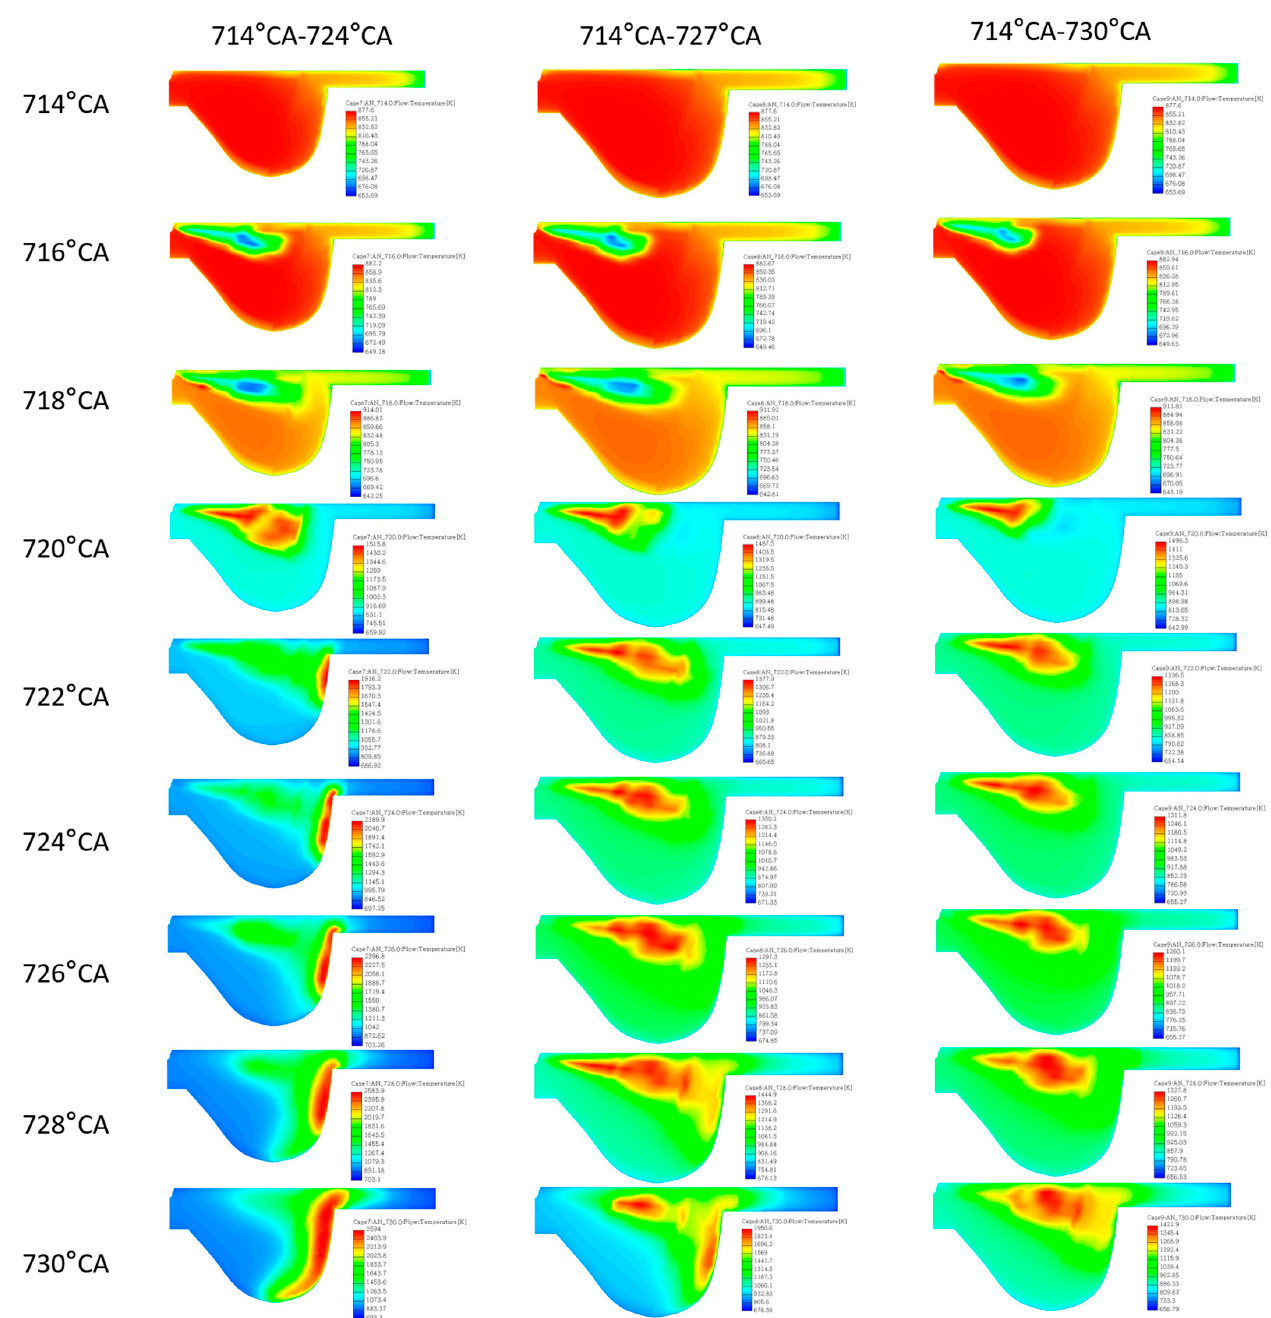
Figure 11. Cylinder temperature field distribution at various crank angles and injection